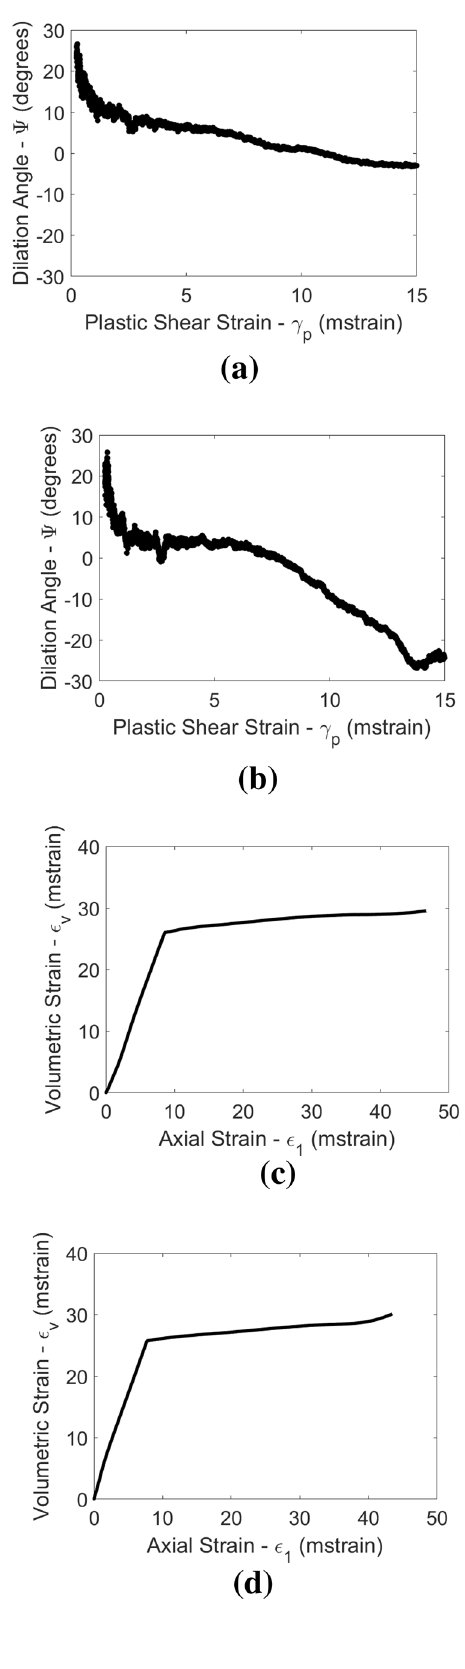
b Fig. 7 Dilation angles as a function of plastic shear strain (top) and volumetric-axial strain plots (bottom) for 0 (cid:3) included angle specimens tested at 88 MPa (left) and 110 MPa (right) of